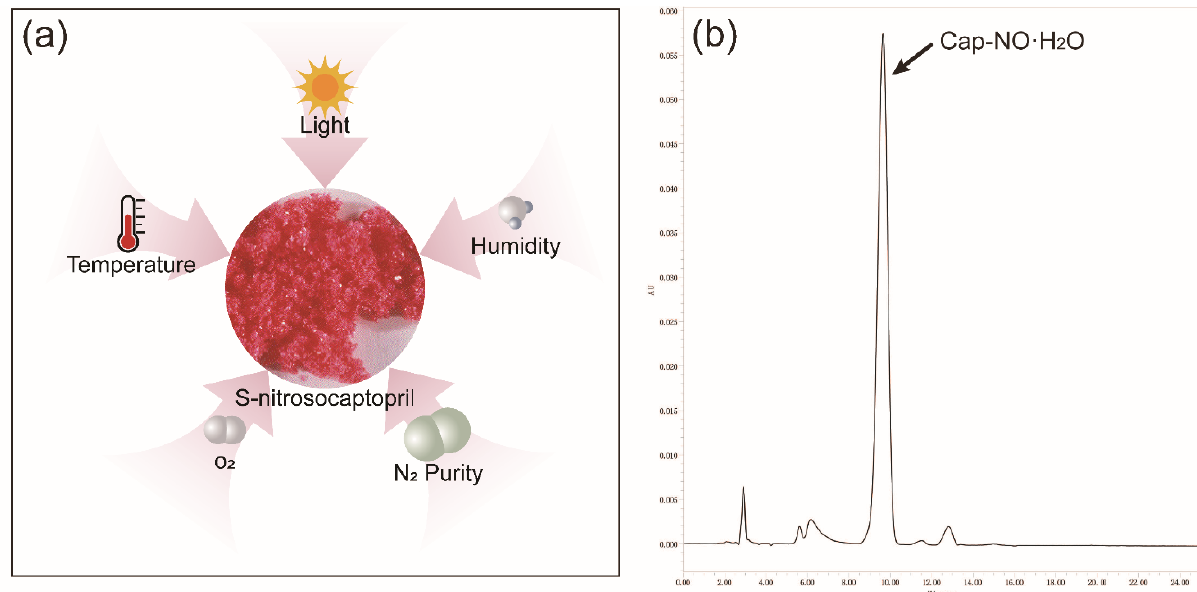
Figure 1. Response test: ( a ) investigated factors and ( b ) HPLC analysis of Cap-NO·H 2 O. The retention time for Cap-NO·H 2 O was 9.65 min.